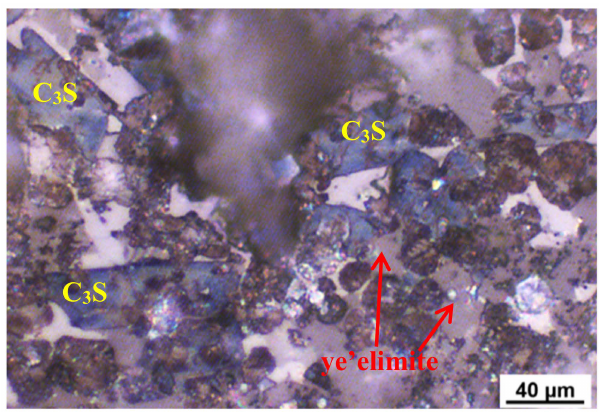
Figure 3. Petrographic picture of clinker observed at the production